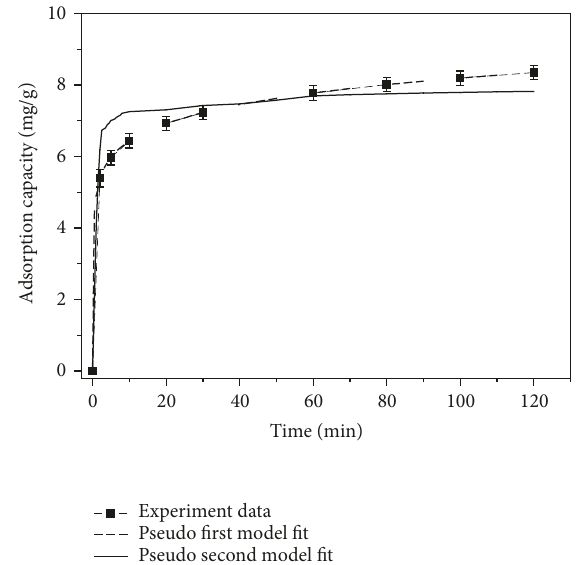
Figure 9: Kinetics models for fitting Sb(III) adsorption using Fe 3 O 4